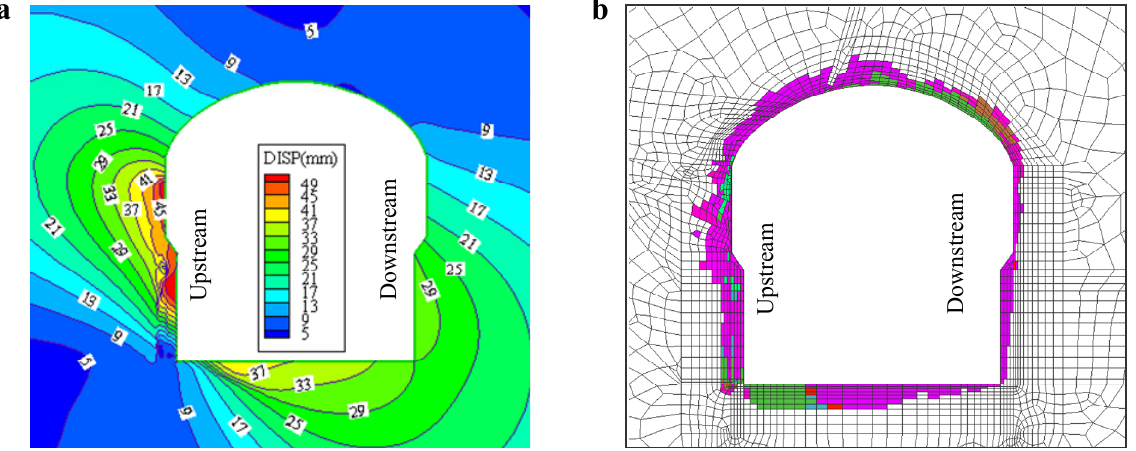
Figure 13. Result of numerical simulation after excavating the third layer at the R 0+263.